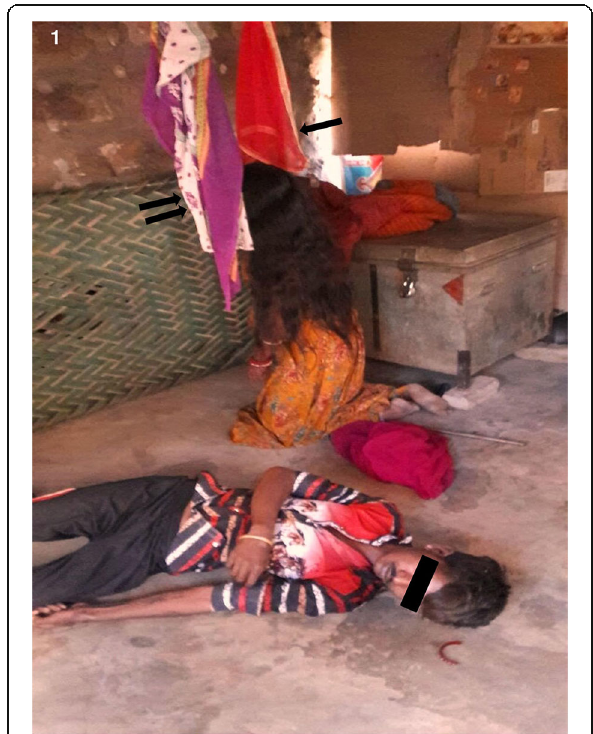
Fig. 1 Body of the deceased female partially suspending from the ceiling by a cotton cloth (single arrow), while the body of the deceased male lies on the floor with a piece of cloth hanging freely above (double arrow), other end of the cloth was tied to the ceiling